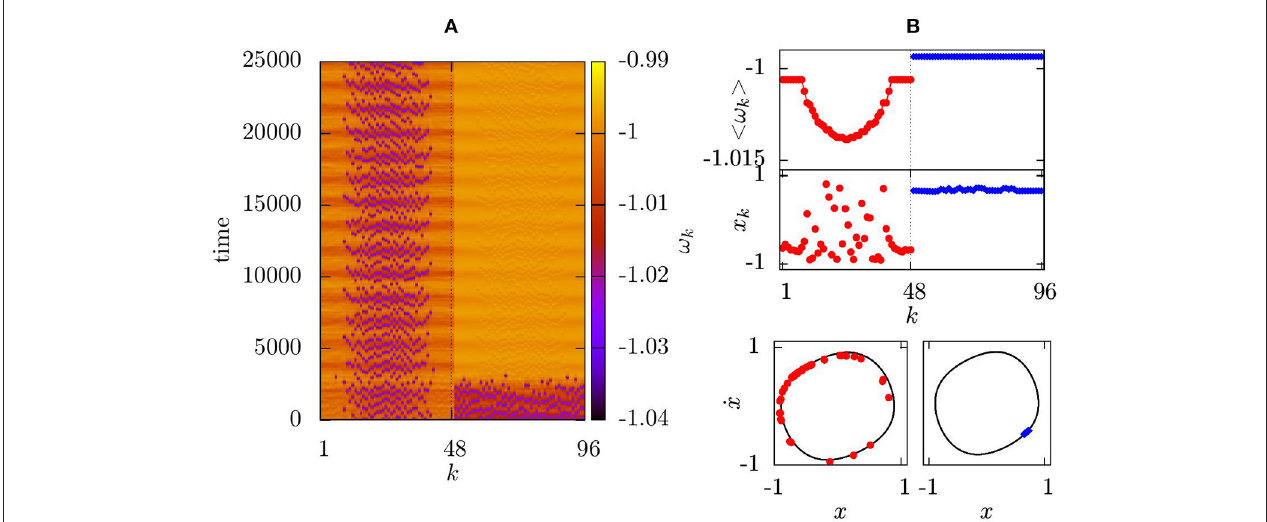
FIGURE 2 | Mean phase velocities for a two-layer system of N = 48 oscillators in each layer with R 1 = R 2 = 16, ε = 0.2, a (1) = a (2) = 0.02, a inter = 0.002, b inter = 0.001. Layer 1 is controlled with K a = 2, K s = 0.5, layer 2 is uncontrolled with b (2) − = b (2) + = 0.0027. Oscillators k = 1...48 represent the first layer, k = 49...96 the second layer; (A) space-time plot; (B) mean phase velocity profile averaged over 25,000 time units for the first layer (red dots) and the second layer (blue diamonds) (top panel); snapshot of variables x k (middle panel) and snapshot in the ( x k ; ˙ x k ) phase space at t = 25,000 (bottom